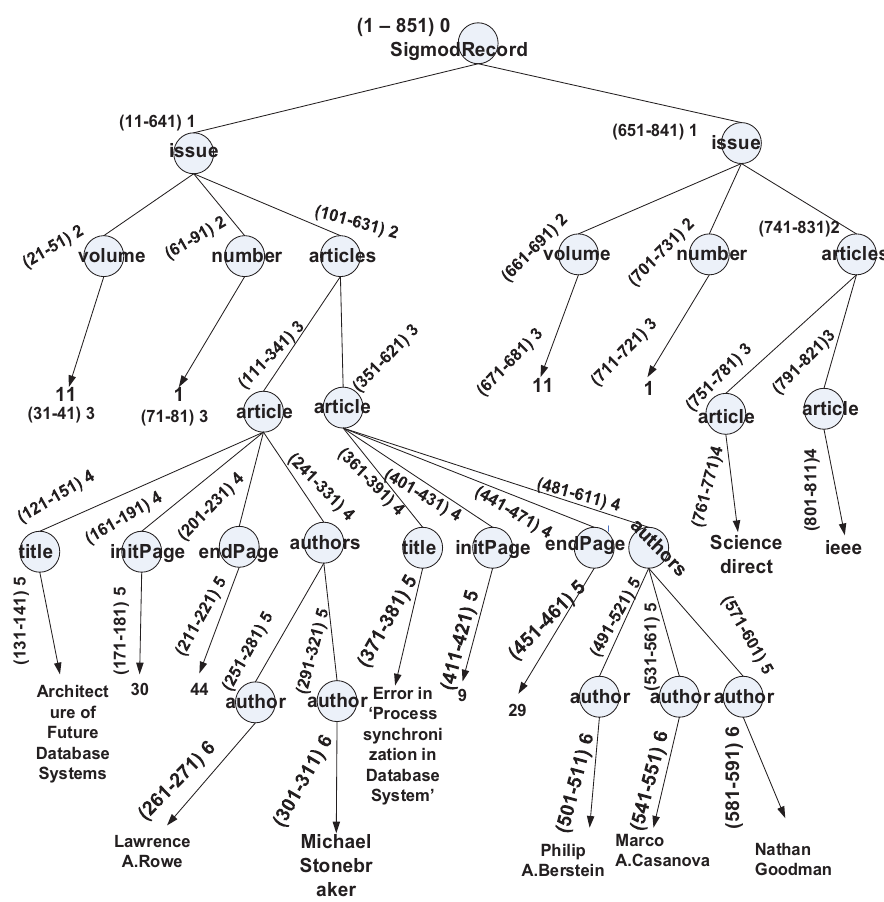
Figure 2. The ORD-GAP labeling